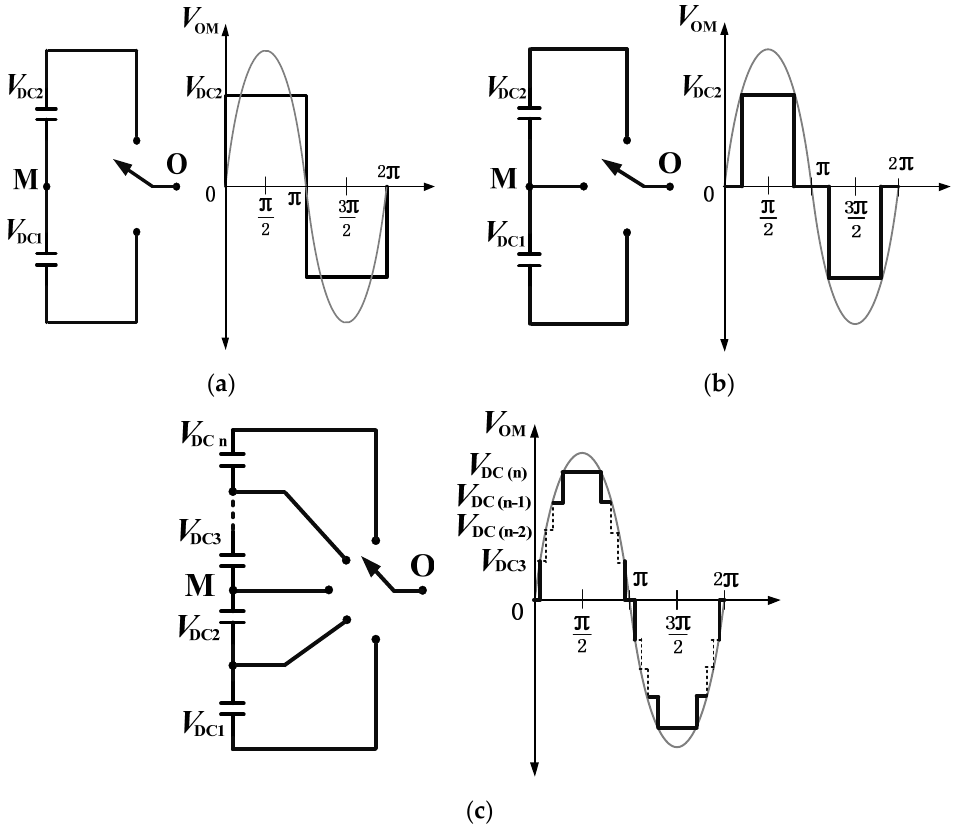
Figure 14. Simplified circuits representation and resulted output voltage waveforms of ( a ) two-level ( b ) three-level and ( c ) n -level inverters [18]